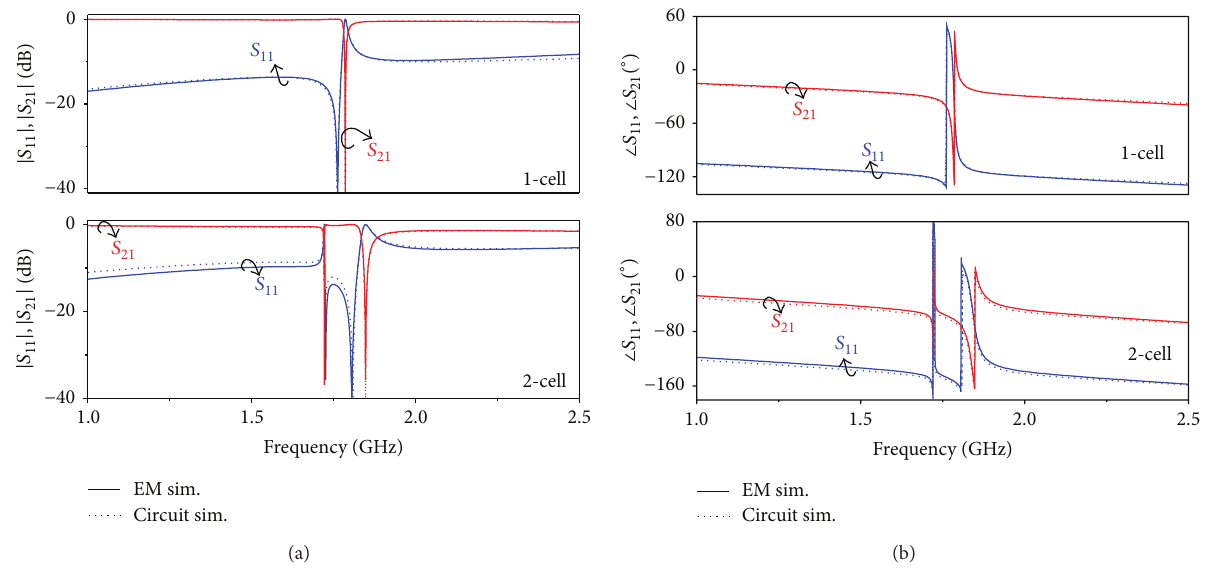
Figure5:Magnitude(a)andphase(b)ofthelosslesstransmission( 𝑆 21 )andreflection( 𝑆 11 )coefficientsforaunitcellandfortwocascadedunit cells of the structure in Figure 4. The extracted circuit parameters are 𝐿 = 1.01 nH, 𝐶 = 1.40 pF, 𝐿 𝑠 = 17.66 nH, 𝐶 𝑠 = 0.45 pF, 𝑀 = 0.72 nH, and 𝑀 𝑅 = 1.17 nH. From [34], reprinted with permission.